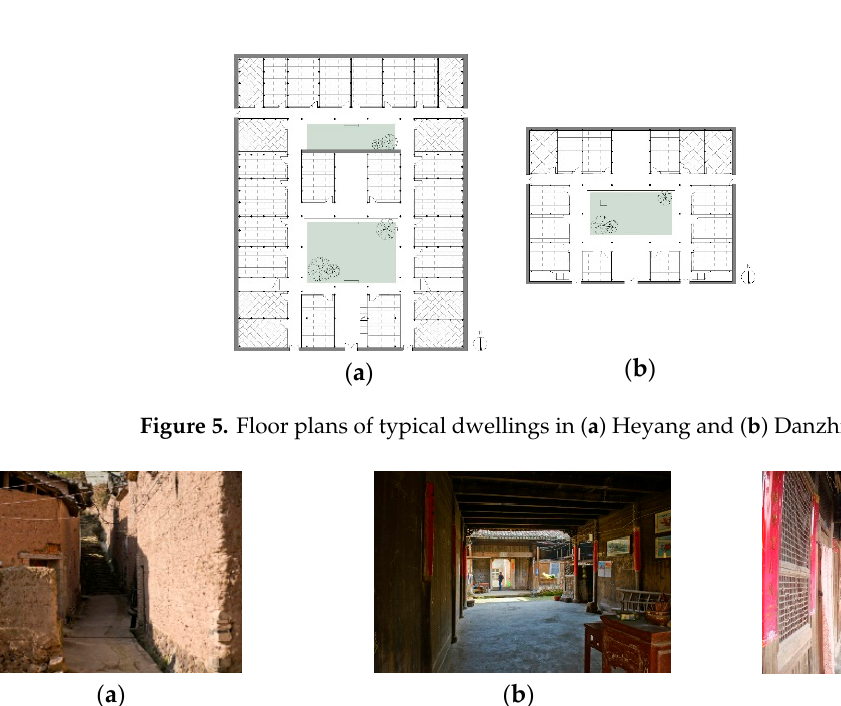
Figure 6. Typical ( a ) cooling avenue, ( b ) living room, and ( c ) corridor views of subject buildings.